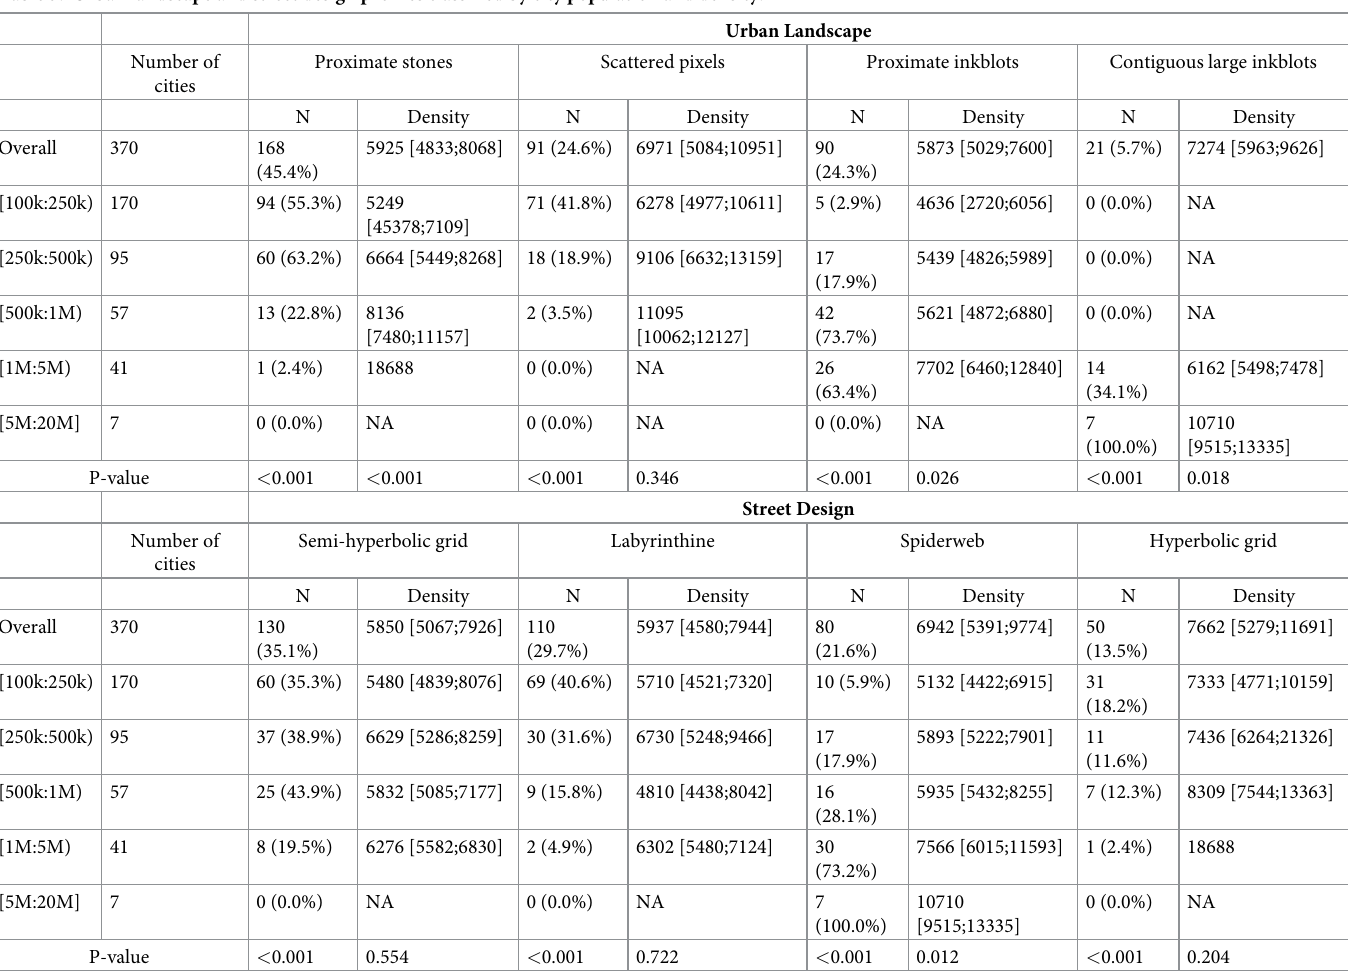
Table 5. Urban landscape and street design profiles classified by city population and